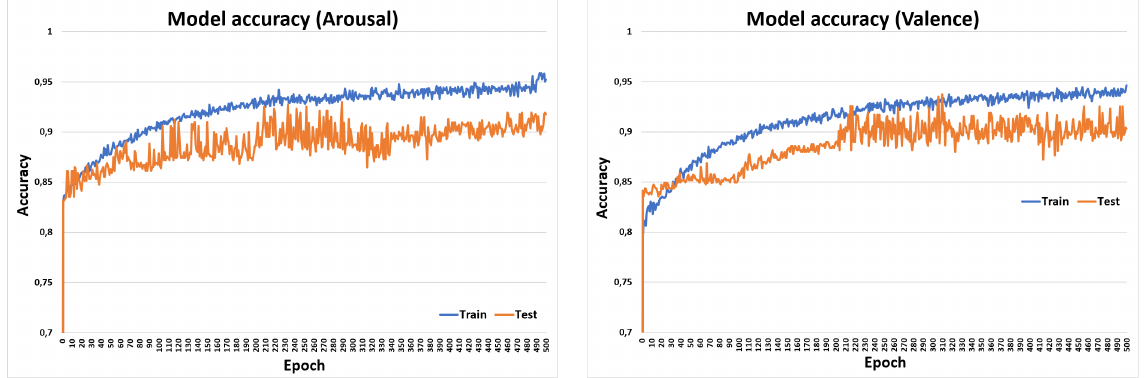
Figure 3. Full system accuracy for Arousal ( left ) and Valence ( right ).